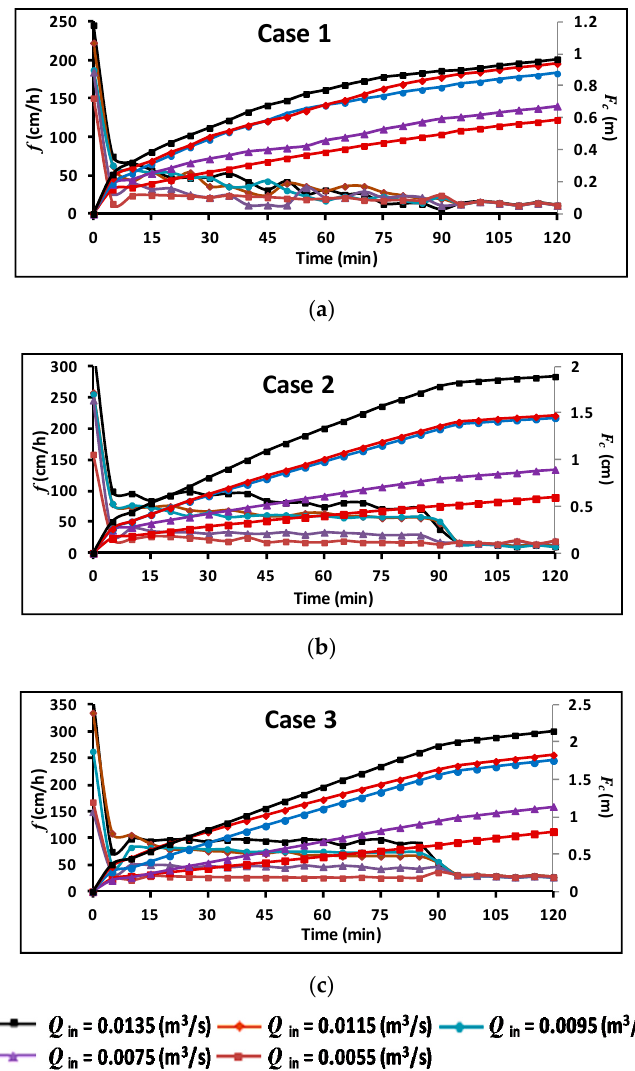
Figure 7. The changes in infiltration rate f p and cumulative infiltration F with time in the grassed channel for different inflow rates: ( a ) h w = 10 cm; ( b ) h w = 15 cm; ( c ) h w = 20 cm. Appl. Sci. 2020 , 10 , 3725